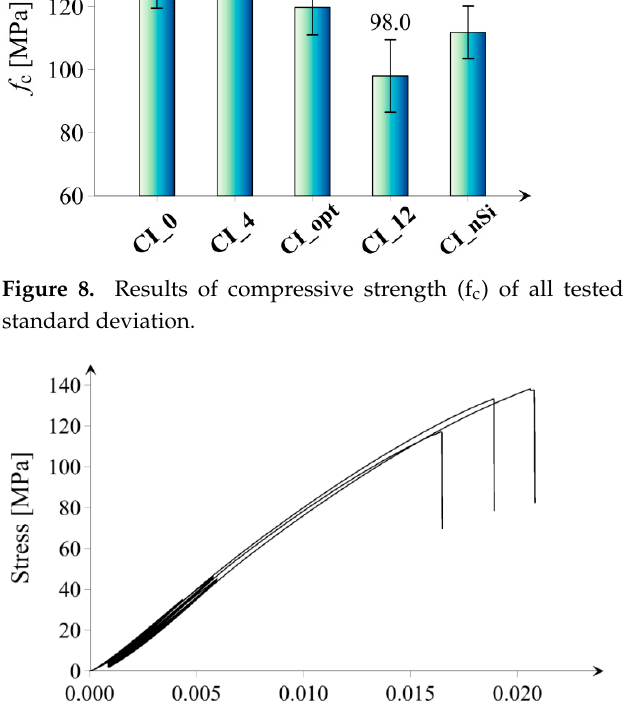
Figure 9. Course of the stress/strain curve from the compression test for three exemplary CI_0 samples.